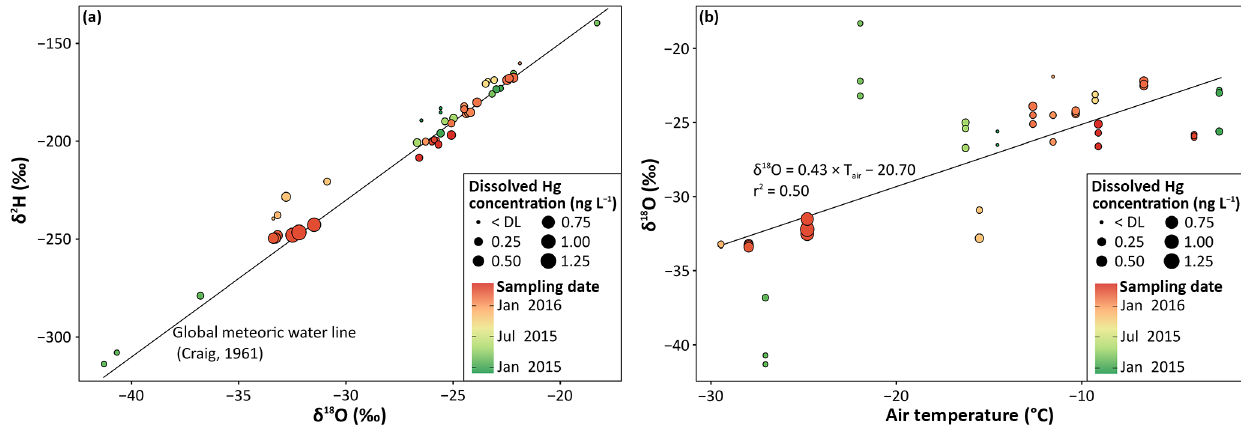
Figure 9. Dissolved Hg concentrations in surface snow samples for 2014 to 2016 in: (a) the δ 2 H vs. δ 18 O diagram and (b) a plot of δ 18 O vs. air temperature ( T air ) during the previous snowfall at Toolik Field